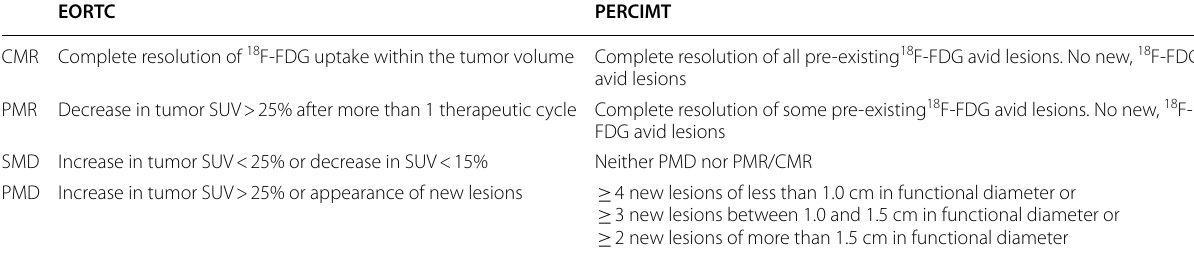
EORTC, European Organization for Research and Treatment of Cancer; PERCIMT, PET Response Evaluation Criteria for Immunotherapy; CMR, complete metabolic response; PMR, partial metabolic response; SMD, stable metabolic disease; PMD, progressive metabolic disease; SUV, standardized uptake value